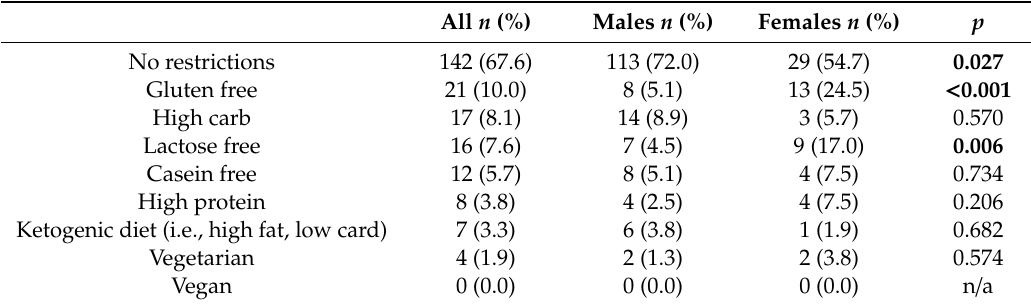
Table 4. Special diet use in pediatric